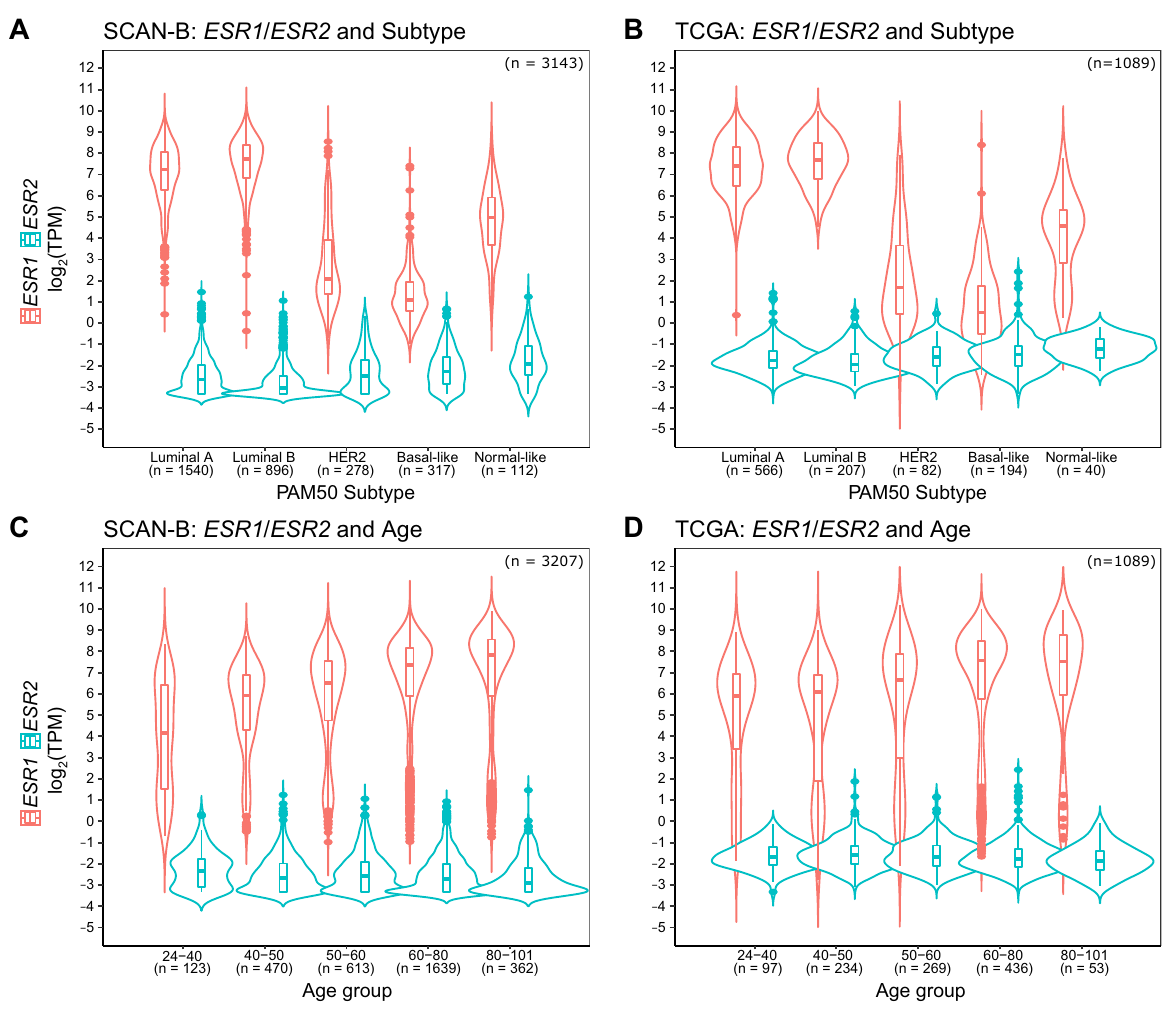
Figure 2. ESR2 mRNA by PAM50 molecular subtype in SCAN-B ( A ) and TCGA ( B ) cohorts, and by age groups (age at diagnosis) in SCAN-B ( C ) and TCGA ( D